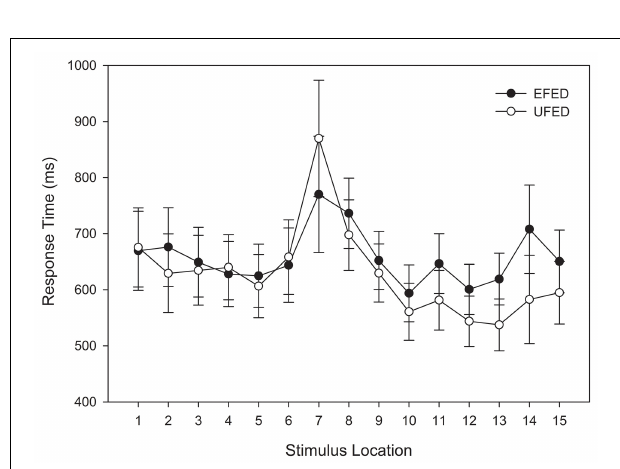
FIGURE 7 | Test categorization response time in equal frequency (EFED) and unequal frequency conditions (UFED). Stimulus values correspond to stimuli selected from the entire stimulus range (i.e., stimuli 1–15). Error bars represent 1 standard error of the mean ( N = 60).